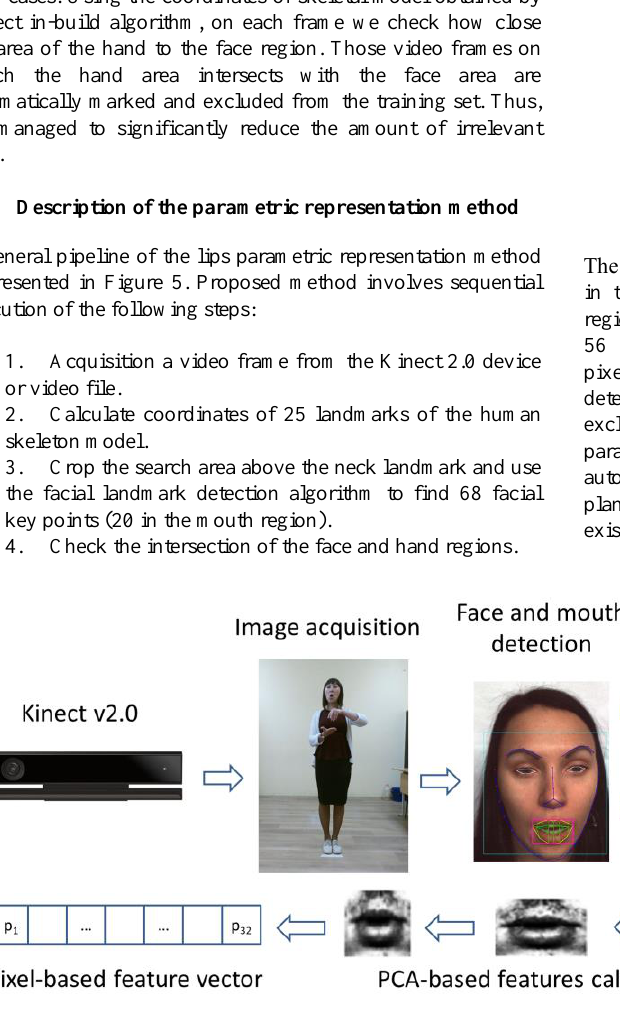
Figure 5. General pipeline of the parametric representation